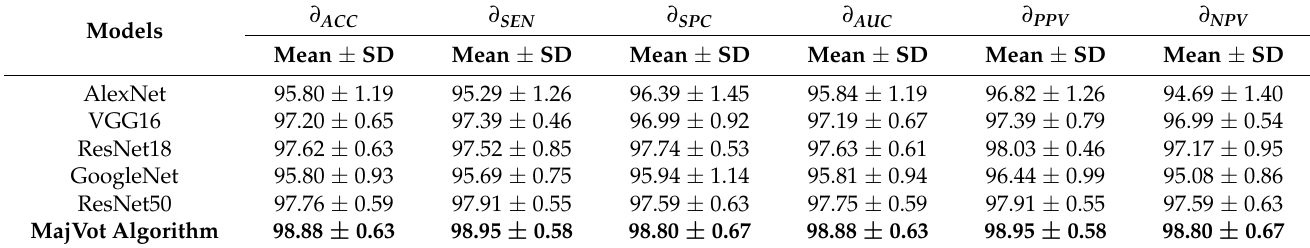
Figure 10. Model-wise accuracy behavior in the five-fold test performance of T2W-MRI data. Table 8. Five-fold test performance of FLAIR-MRI Data.